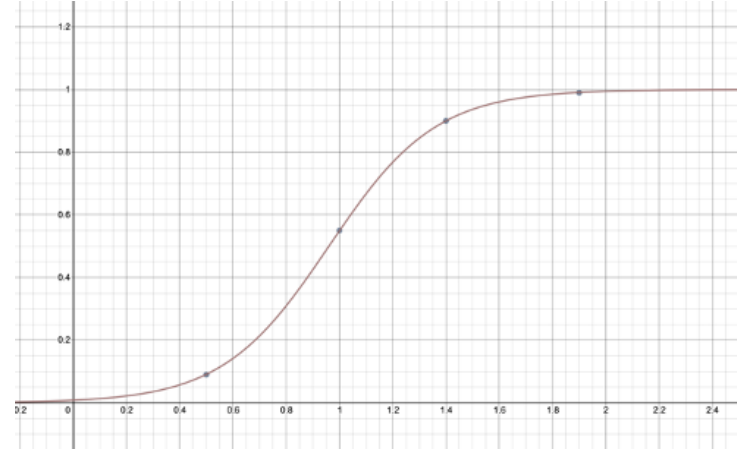
Figure 4. Logistic curve to represent the function of p t = logistic .